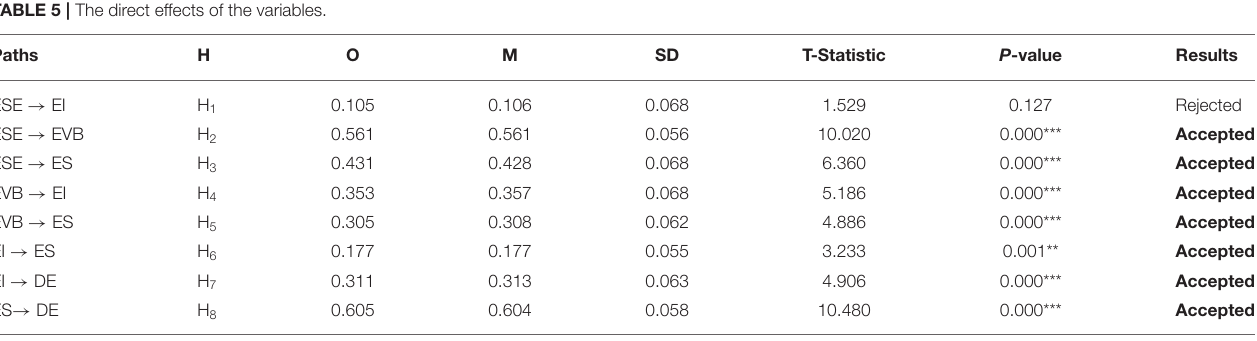
TABLE 5 | The direct effects of the